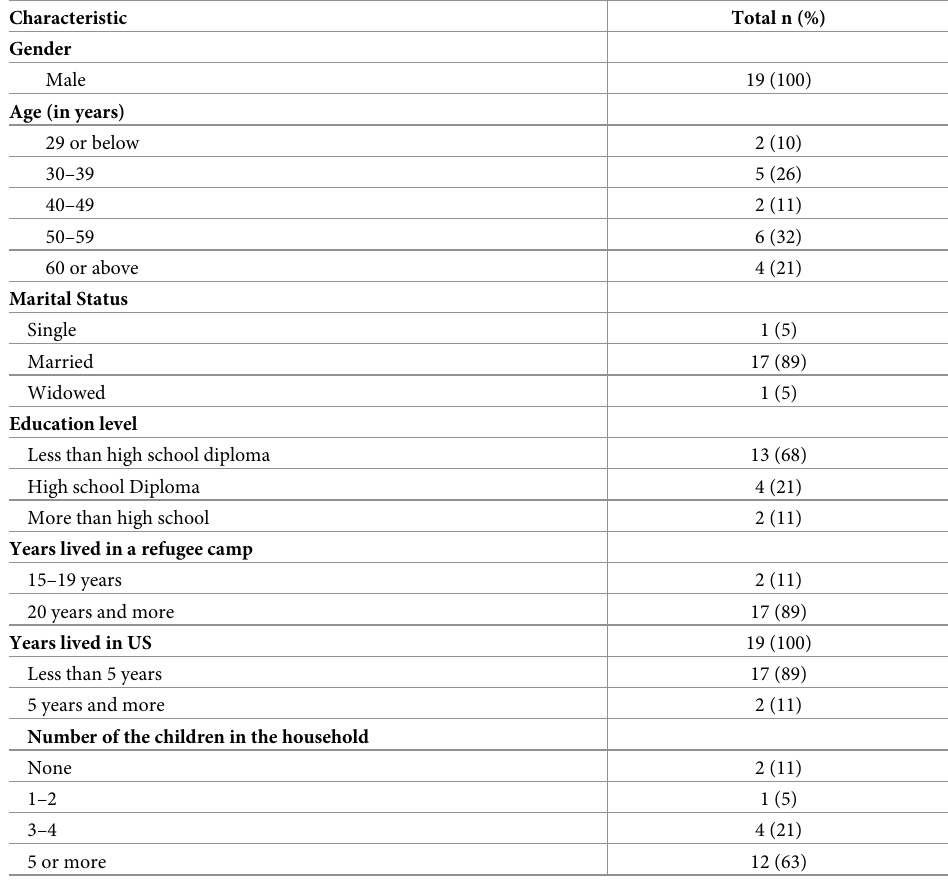
Table 1. Sociodemographic profile of